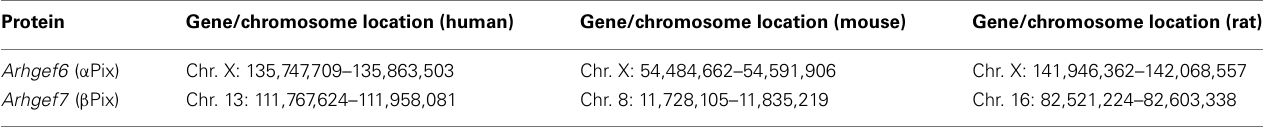
Table 1 | Gene/chromosome locations of α Pix and β Pix. Protein Gene/chromosome location (human) Gene/chromosome location